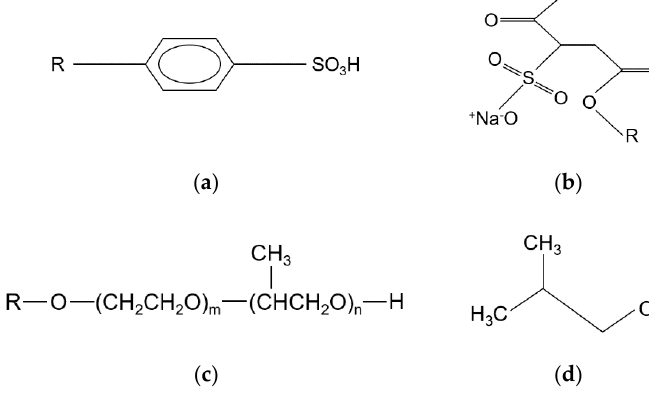
Figure 1. Chemical structures: ( a ) LAS; ( b ) DOSS; (c) LB-95; (d) IBA.